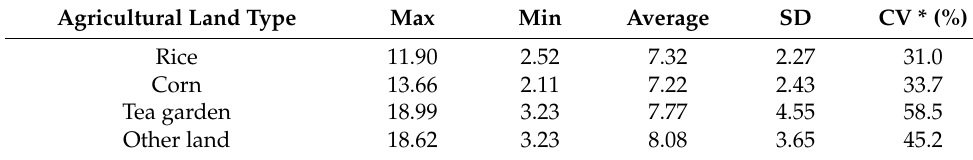
Table 2. Statistics of organic matter content in soils of different agricultural